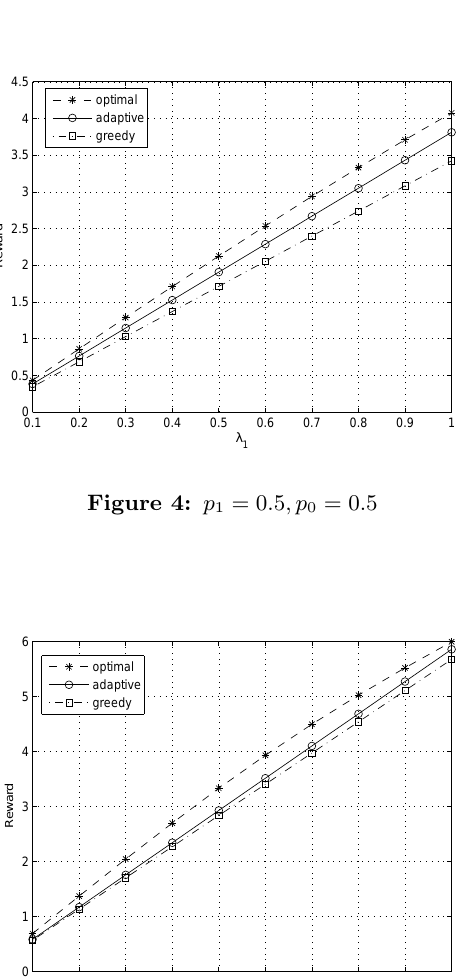
Figure 3: p 1 = 0 : 2 ; p 0 = 0 : 8